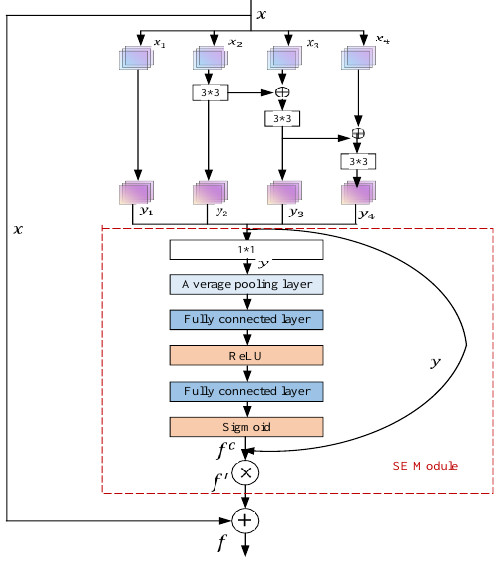
Figure 6. SE-Res2Net network structure diagram.